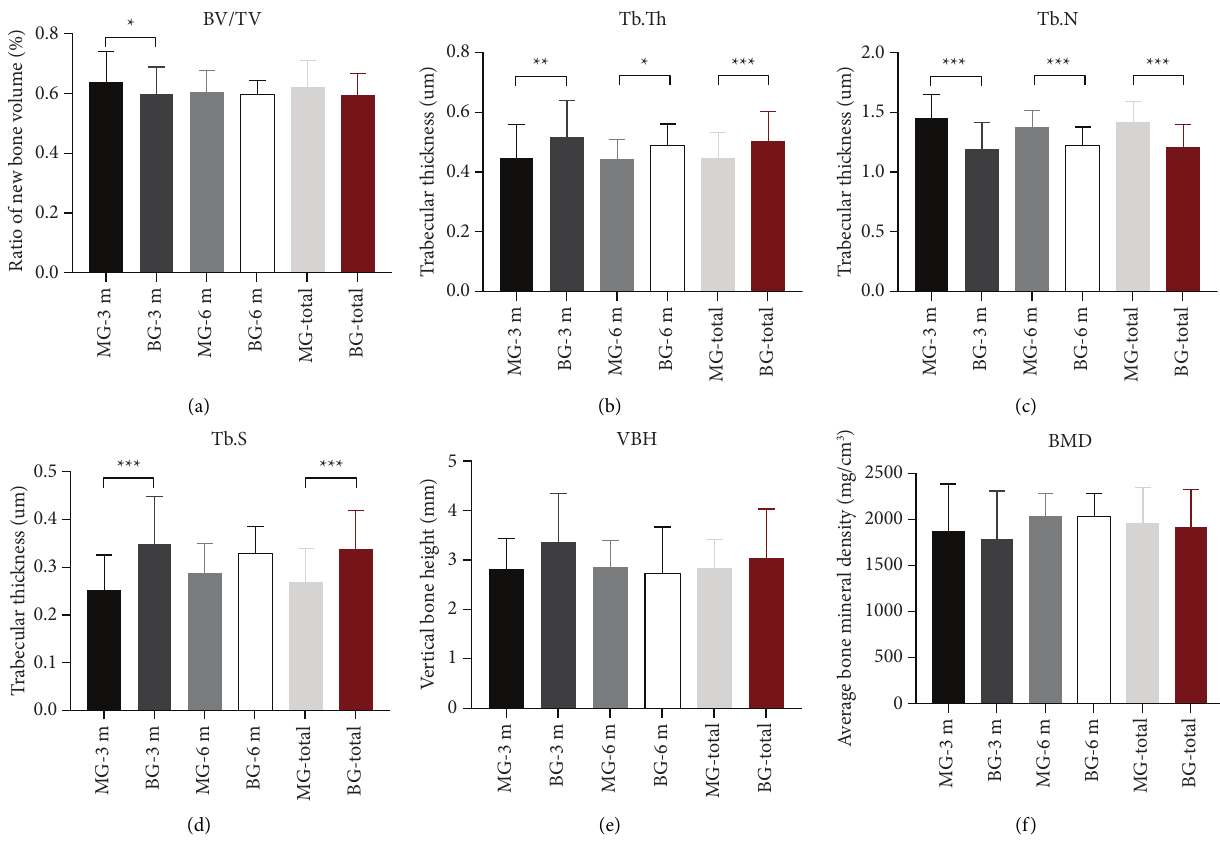
Figure 5: Morphometry of bone defect area using micro-CT. (a) Trabecular volume/total volume of ROI (BV/TV). (b) Trabecular thickness (Tb. Th). (c) Trabecular number (Tb. N). (d) Trabecular separation (Tb. S). (e) Vertical bone height (VBH). (f) Average bone mineral density (BMD). ∗ P < 0 . 05, ∗ ∗ P < 0 .